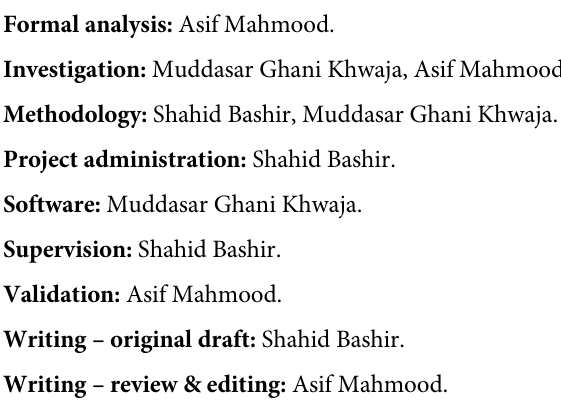
S1 Fig. Confirmatory Factor Analysis (CFA) of the